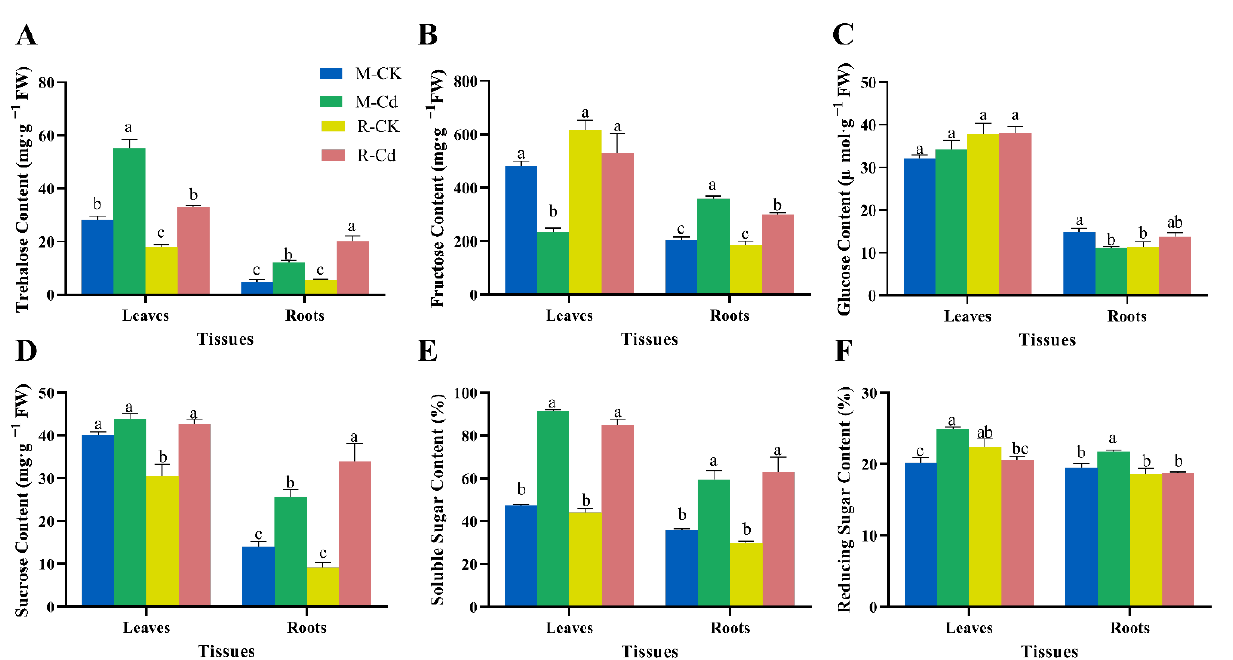
Figure 4. Effects of Cd stress on trehalose ( A ), fructose ( B ), glucose ( C ), sucrose ( D ), soluble sugar ( E ), and reducing sugar ( F ) content in the leaves and roots of the M and R genotypes. The significant differences between M and R genotype were based on one-way ANOVA. The different letters indicate that the difference is significant at a 0.05 level. Data were shown by “means ± SE”. CK and Cd represent treatments of 0 and 1000 μM Cd, respectively.